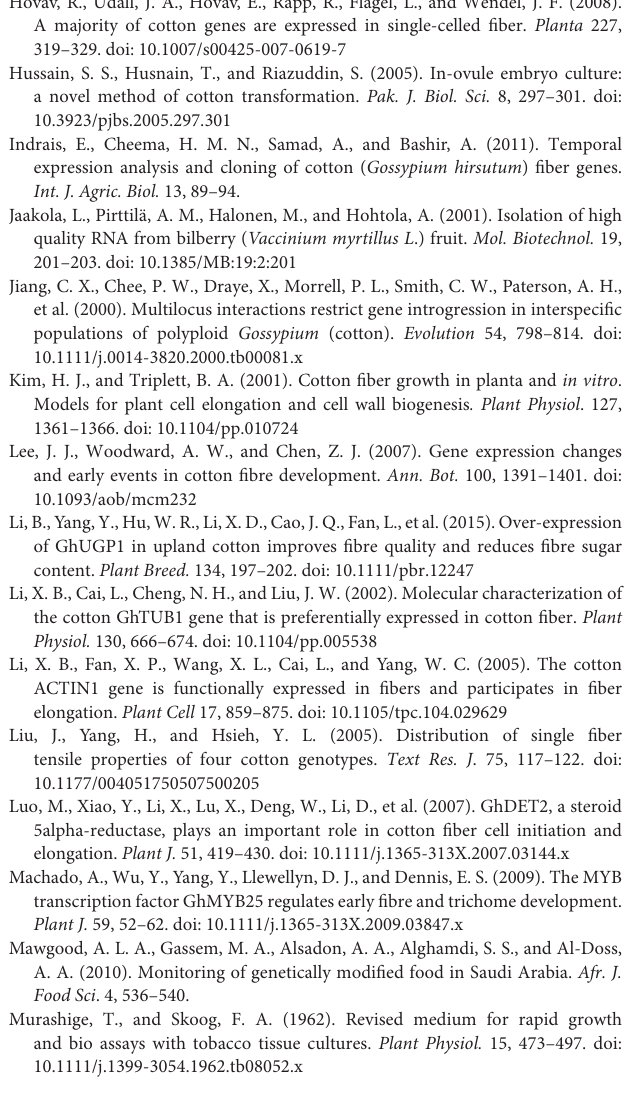
Component biplot. Supplementary Table 1 | Primers for analysis of transgenic cotton